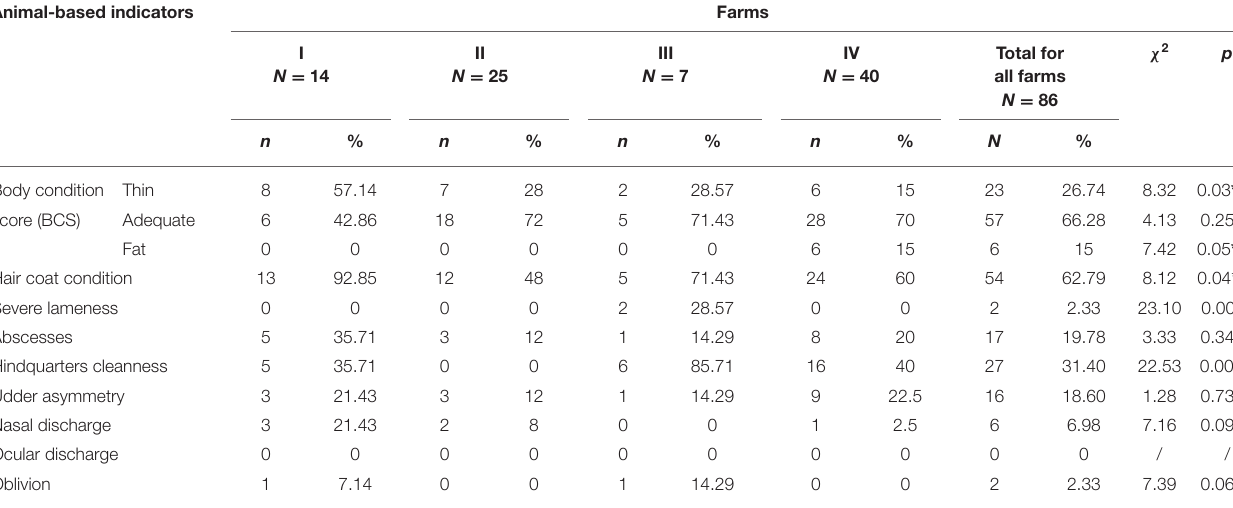
TABLE 2 | Prevalence of welfare parameters in 86 individual goats examined in four farms in Serbia. Animal-based indicators